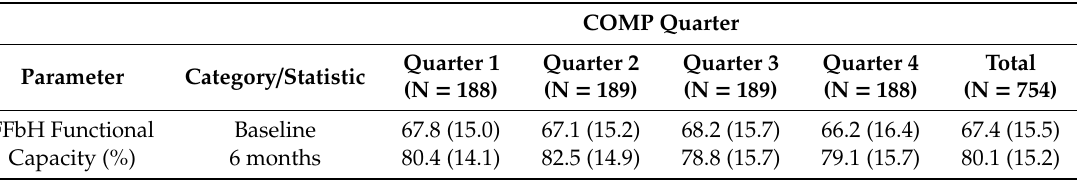
Table A1. Descriptive FFbH (hip and knee OA) at baseline given as mean (SD). Multiple linear regression model adjusted for age, sex, BMI, and